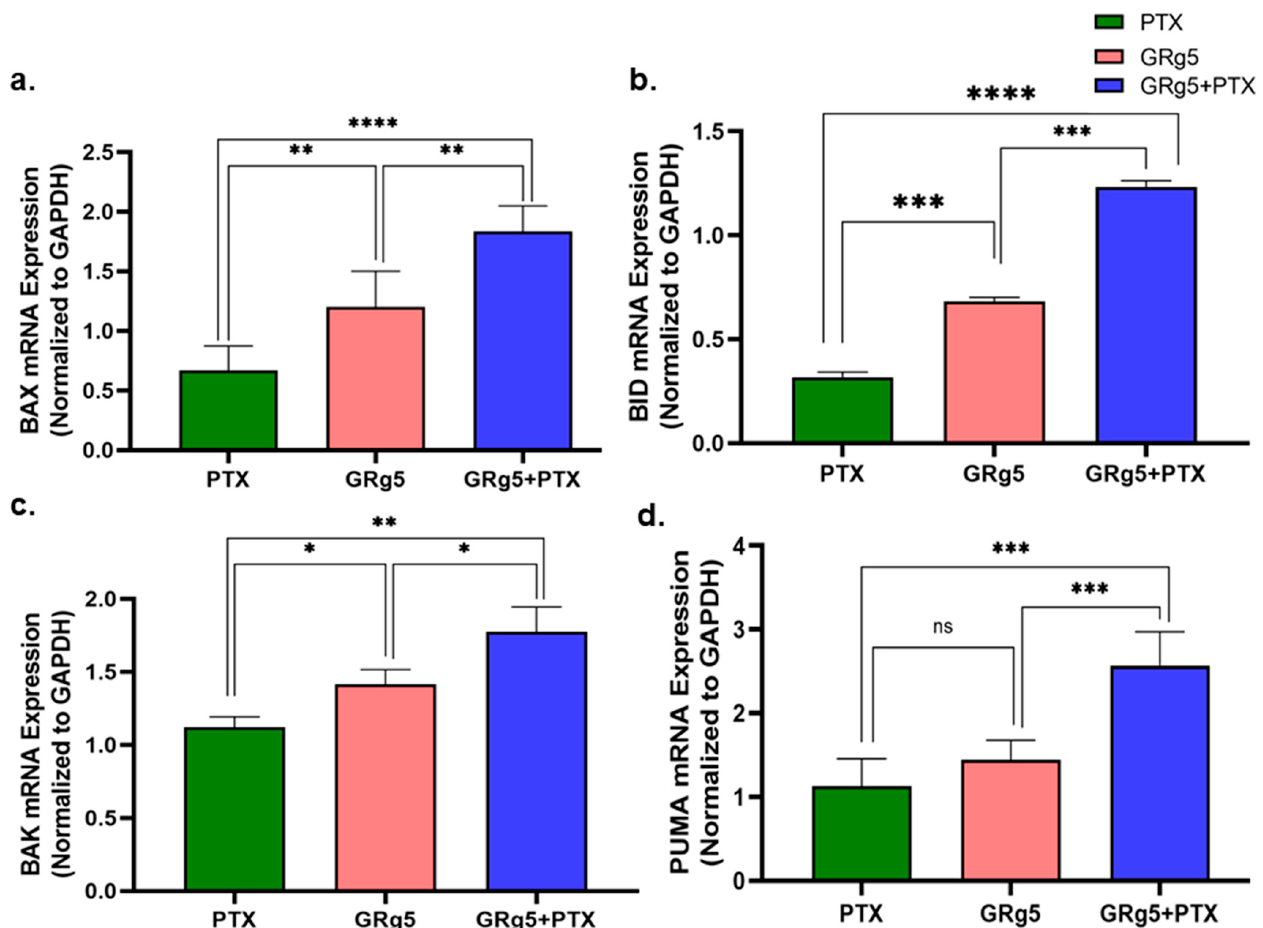
Figure 7. Quantitative RT-PCR analysis of pro-apoptotic regulatory genes: Expression of different pro-apoptotic genes ( a ) Bax, ( b ) BID, ( c ) BAK, and ( d ) PUMA in control and treated HeLa-PTX-R cells quantified relative to the control and normalized against the reference gene, GAPDH. Data is represented as mean ± S.E.M of three individual observations. Statistical significance was assessed using One way-ANOVA and Tukey’s post hoc test. ****, p < 0.0001; ***, p < 0.001; **, p < 0.01; *, p ≤ 0.05; ns, non-significant.